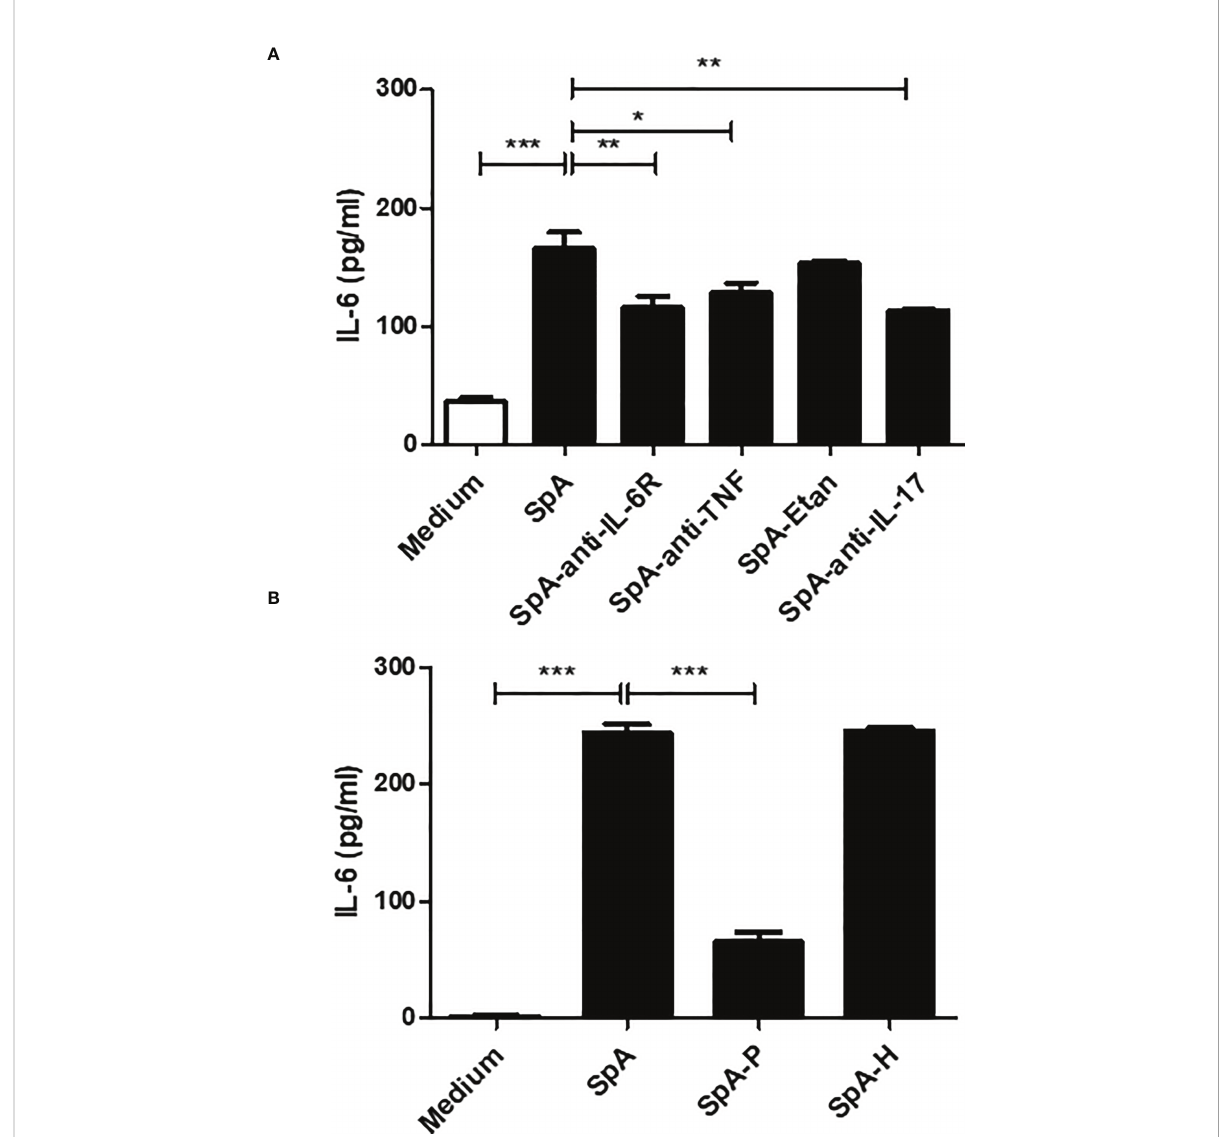
FIGURE 3 Synovial proteins promote IL-6 secretion by FLS. (A) SW982 FLS were incubated with a pool of peripheral SpA synovial fl uid in the absence or presence of anti-IL-6R (tocilizumab), anti-TNF (in fl iximab), TNF inhibitor (etanercept, Etan) or anti-IL-17 (secukinumab). Non-stimulated FLS were used as a control. After 48h, IL-6 levels were measured in the culture supernatants. (B) SW982 FLS were stimulated with a pool of peripheral SpA SF pre-treated with proteinase K (SpA-P) or hyaluronidase (SpA-H). Data of at least two independent experiments are shown. Values are presented as the mean ± SEM. *: p<0.05; **: p<0.01, ***: